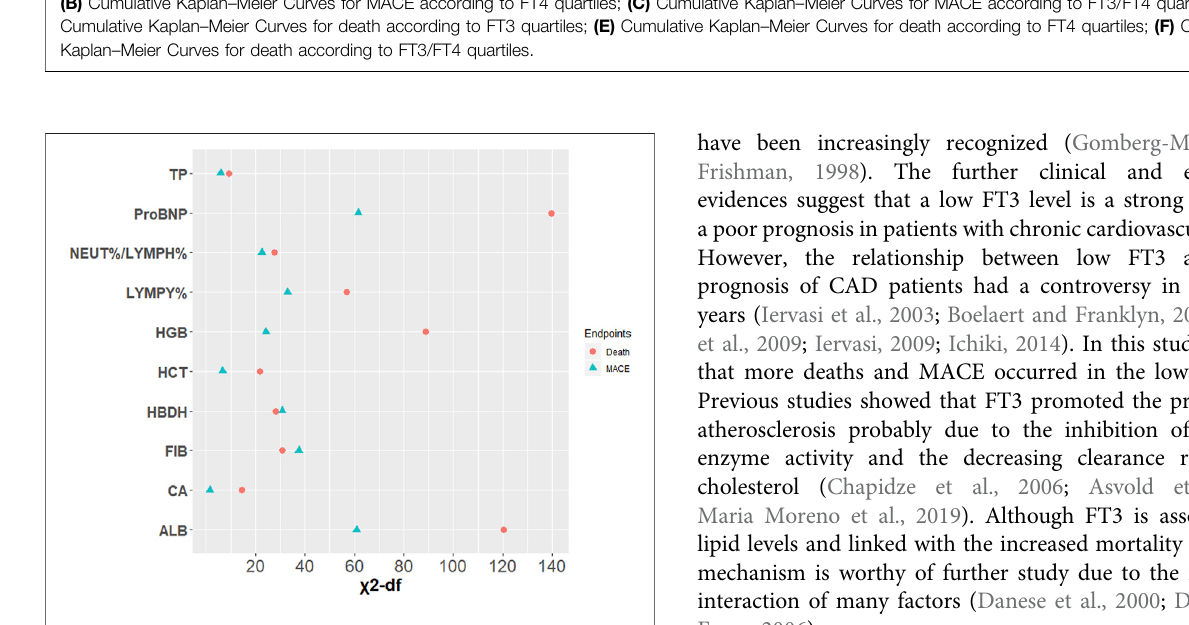
Frontiers in Molecular Biosciences |